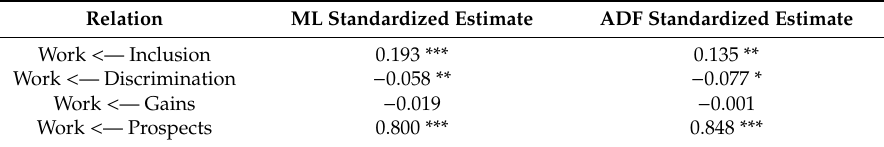
Table 9. Regression weights: parameter estimates, standard errors and critical ratios.